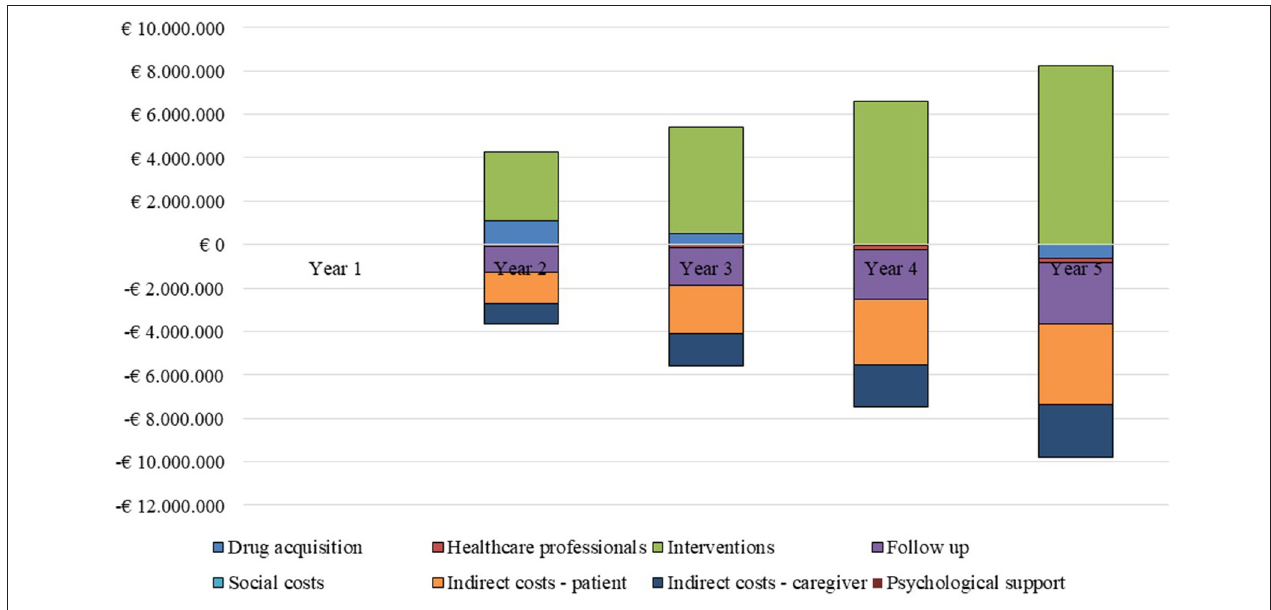
FIGURE 1 | Differential analysis by cost driver and year of analysis.